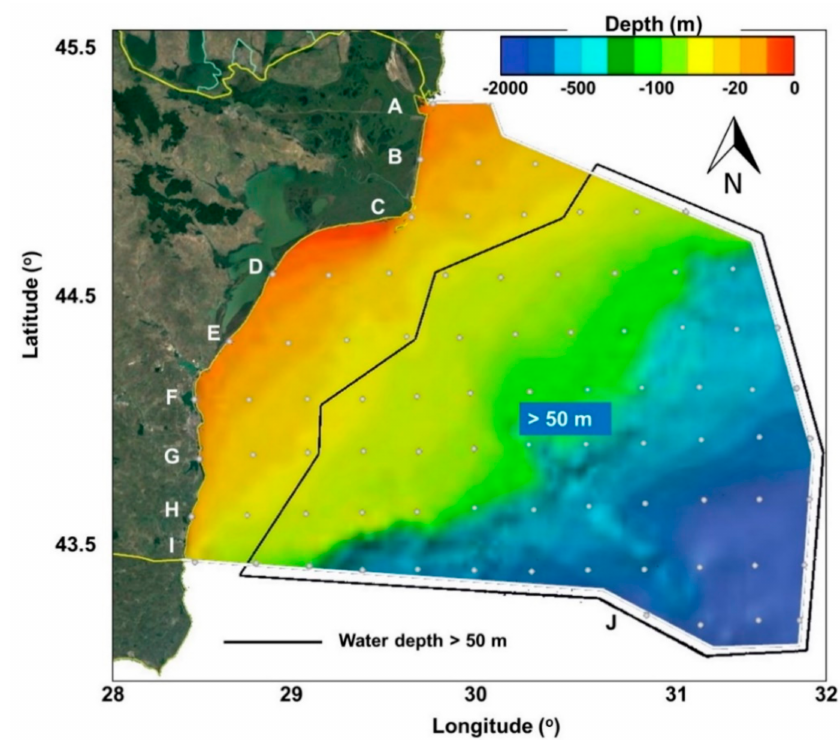
Figure 1. Representation of the Romanian exclusive economic zone (EEZ) considering the spatial map and the grid points defined. The horizontal reference lines (denoted from A to J from north to south) include points distributed along a grid defined by an approximate length of 20 km (along x and y